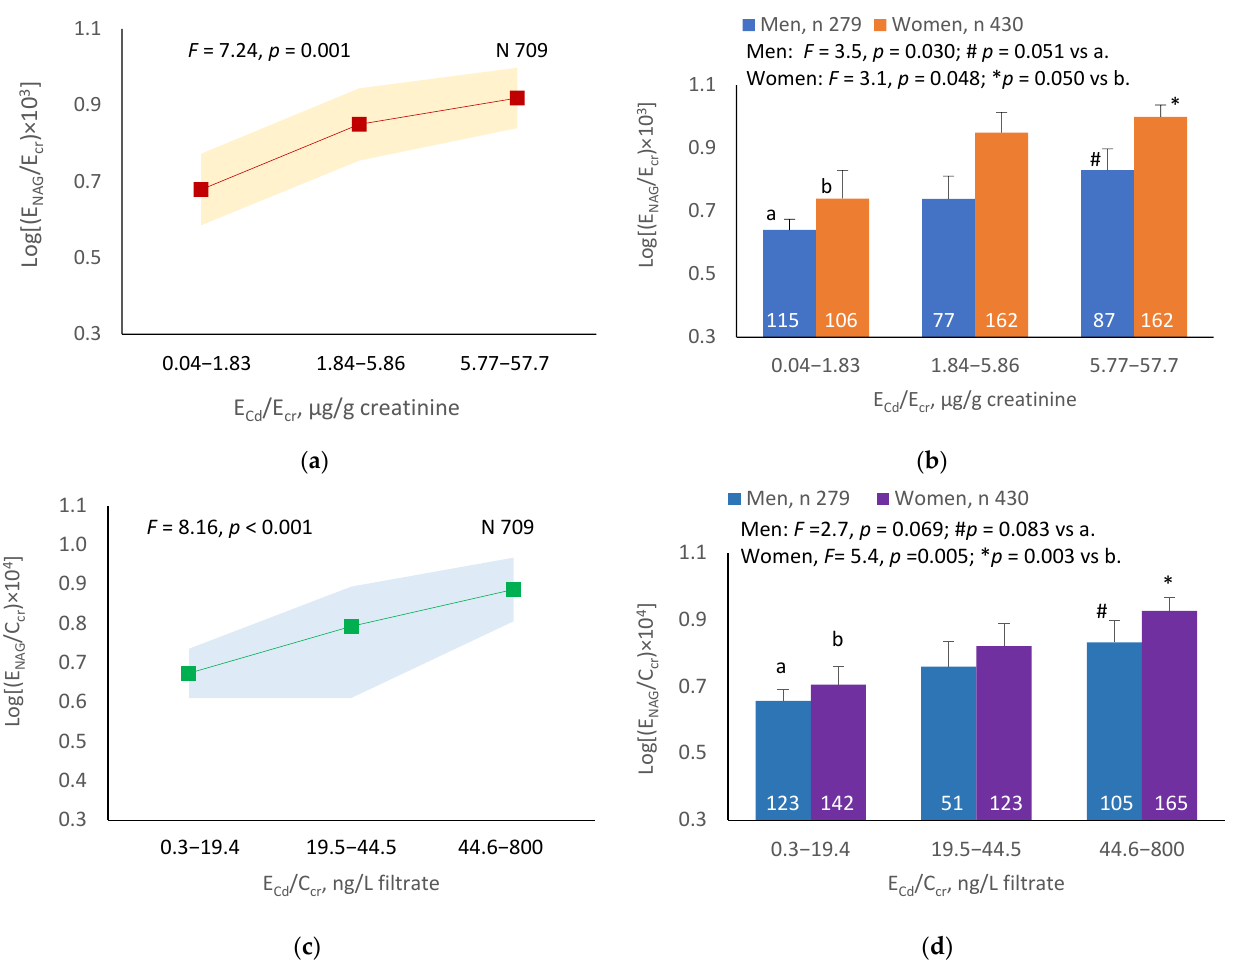
Figure 2. Cadmium-dose-related increases in NAG excretion. The color-coded area graphs depict NAG excretion means as log[(E NAG /E cr ) × 10 3 ] values with variances for subjects with E Cd /E cr Levels 1, 2 and 3 ( a ) and NAG excretion means as log[(E NAG /C cr ) × 10 4 ] with variances in subjects with E Cd /C cr Levels 1, 2 and 3 ( c ). The bar graphs show NAG excretion means as log[(E NAG /E cr ) × 10 3 ] values in men and women with E Cd /E cr Levels 1, 2, and 3 ( b ) and NAG excretion means as log[(E NAG /C cr ) × 10 4 ] in men and women with E Cd /C cr Levels 1, 2 and 3 ( d ). Where appropriate, statistical comparisons are made within each sex between NAG excretion means in bars a and b. The GM (SD) values of E Cd /E cr at Levels 1, 2 and 3 are 0.51 (0.50), 3.43 (1.10) and 10.94 (7.33) µg/g creatinine, with the corresponding number of subjects being 221, 239 and 249, respectively. The GM (SD) values of E Cd /C cr at Levels 1, 2 and 3 are 5.18 (5.72), 29.6 (6.73) and 97.3 (97.7) ng/L filtrate, with the corresponding number of subjects being 265, 174 and 270, respectively.